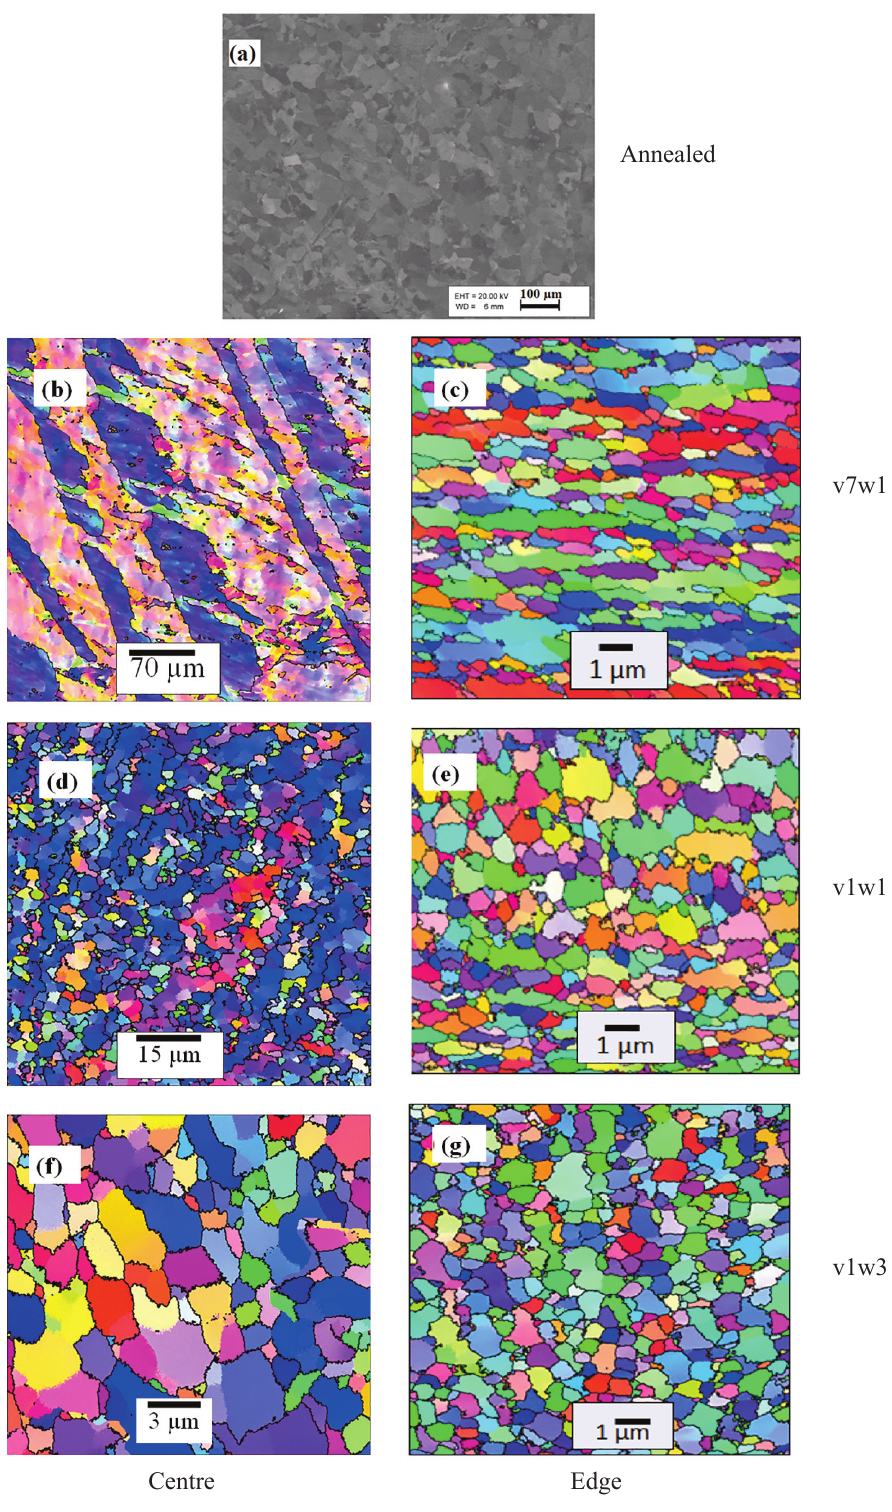
Fig. 3. SEM/EBSD analysis of the microstructure of samples: (a) Initial specimen (annealed), (b,c) v7w1, (d,e) v1w1, and (f,g) v1w3. The left column of the EBSD images was taken from the central zone and the right ones were taken from the edge zone of the